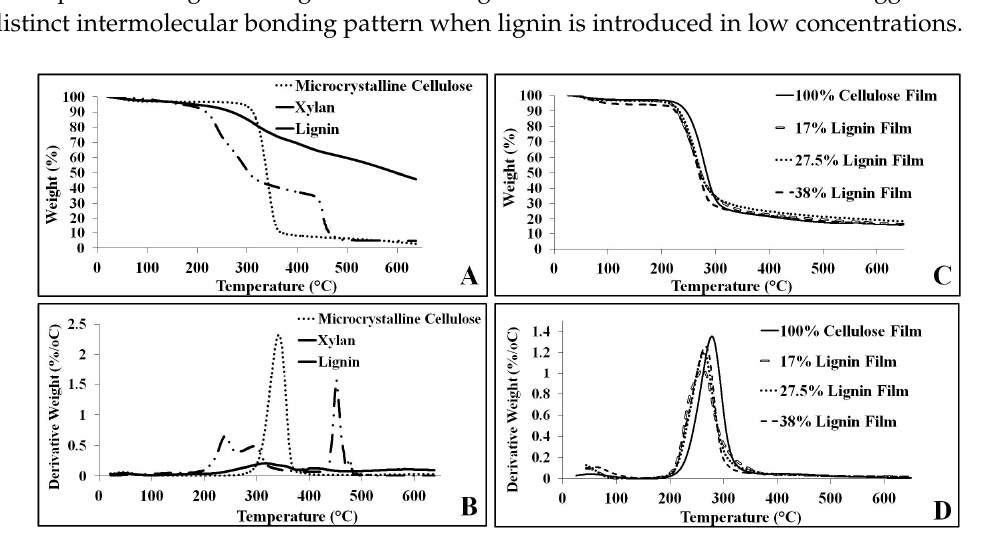
Figure 5. TGA percent weight decomposition analysis for ( A ) pure lignocellulose components; and ( C ) blended films; and TGA derivative percent weight decomposition analysis for ( B ) pure lignocellulose components and ( D ) blended films. Table 2. TGA decomposition temperatures of pure material components and experimental results.